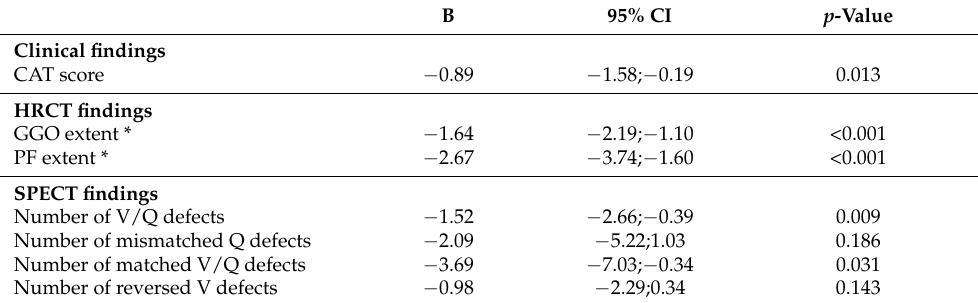
Table 5. Association between CAT score, V/Q scintigraphy defects or HRCT findings with diffusion capacity (DLco %predicted) in patients 4 months after COVID-19 (n = 64) using univariate linear regression. B 95%